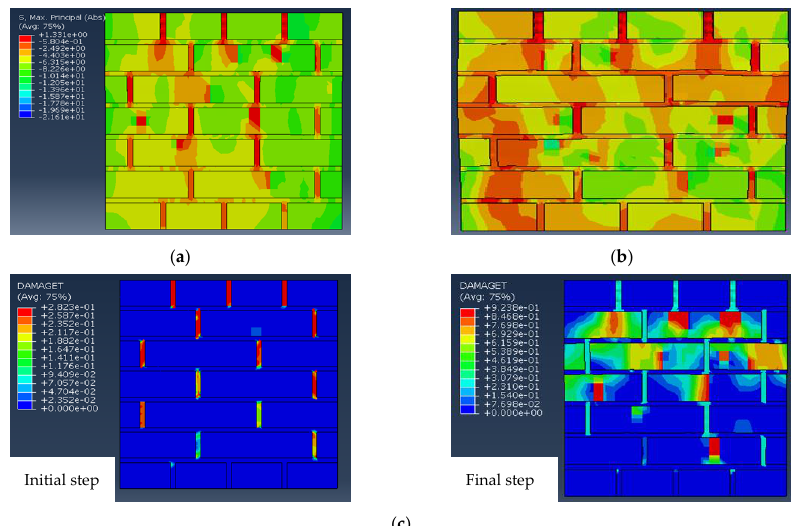
Figure 13. ( a ) Principal stress; ( b ) normal stress in the direction y (S22); ( c ) evolution of damage in unreinforced wall MCB (θ = 90°).